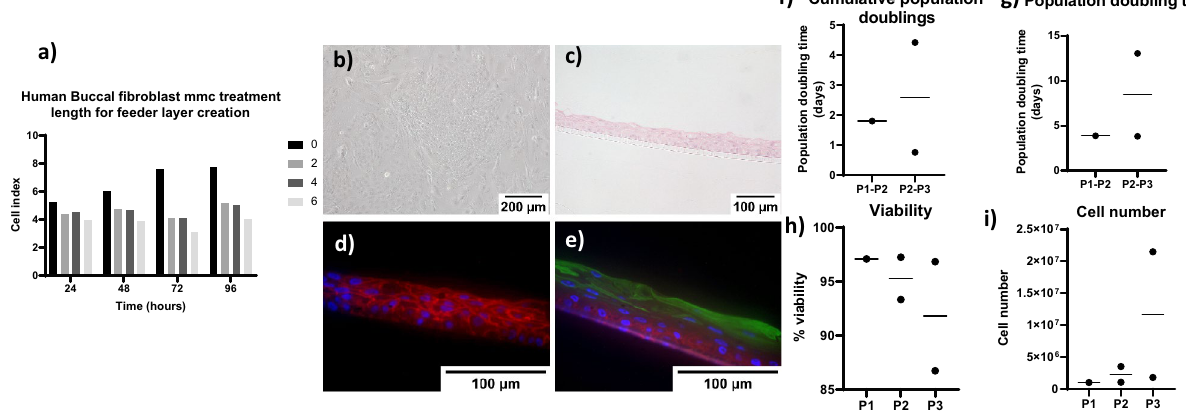
Figure 6. Human buccal cells. Fibroblasts underwent automated digestion and were plated onto fibronectin coated tissue culture plasticware for 3 days before media was changed to DMEM + HPL for further passages. Fibroblasts underwent MMC treatment for 0, 2, 4 and 6 h. 2 h stops cell proliferation without promoting apoptosis ( a ) n = 1. The epithelial cells underwent automated digestion and were plated onto a growth arrested human fibroblast feeder layer in HPL + Y-27632 media. At passage 3 they were seeded into a non-contact co-culture with human growth arrested fibroblast feeder layer. They underwent submerged culture for 3 days and were lifted to ALI for 14 days to allow differentiation. Phase image shows cells at p0 ( b ) H &E ( c ), E-cadherin staining ( d ) and cytokeratin 4 (green) found in intermediate and differentiated cells and Basal cell mark integrin β4 (red) ( e ) when differentiated at ALI. Population doublings ( f ), population doubling time ( g ), viability ( h ) and cell number ( i ), up to passage 3 were recorded, Scale bar shows 200 µm and 100 µm, n =